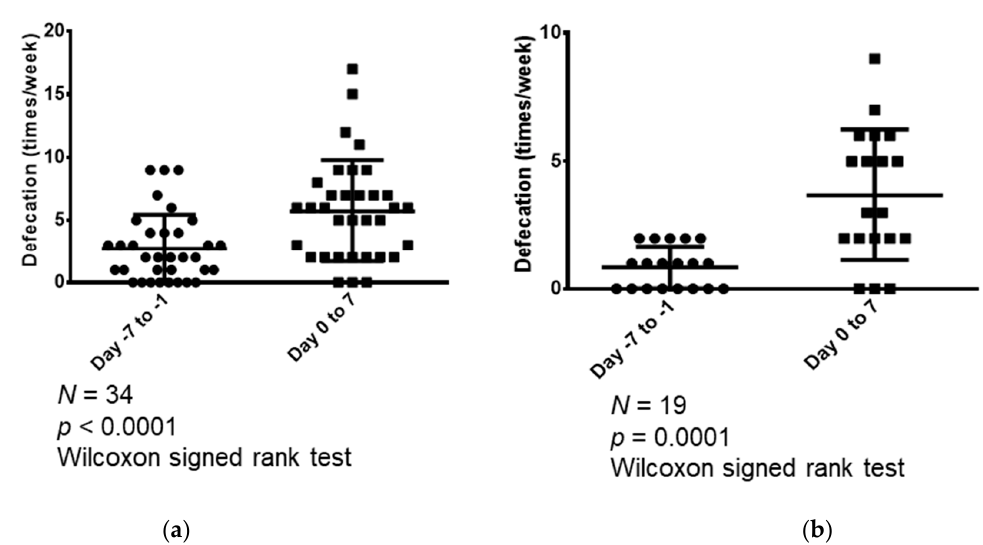
Figure 2. Comparison of the weekly number of bowel movements in the week (seven days) prior to and the week following naldemedine initiation. ( a ) Comparison of the number of bowel movements that occurred during the seven days before and seven days following naldemedine initiation in all patients (n = 34); ( b ) Comparison of the number of bowel movements that occurred during the seven days before and seven days following naldemedine initiation in patients who had less than three bowel movements in the seven days prior to naldemedine administration (n = 19). Table 4. Toxicities during naldemedine treatment.